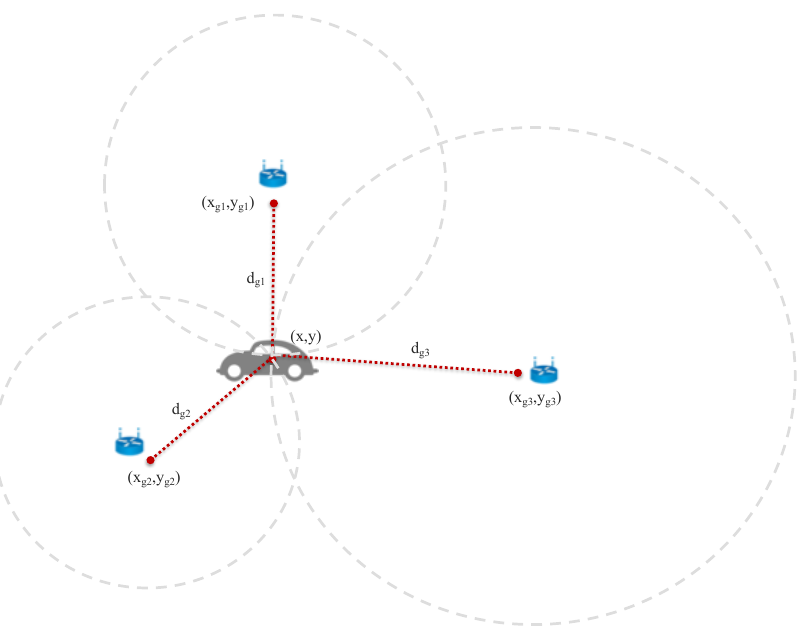
Figure 4. Graphical representation of the trilateration